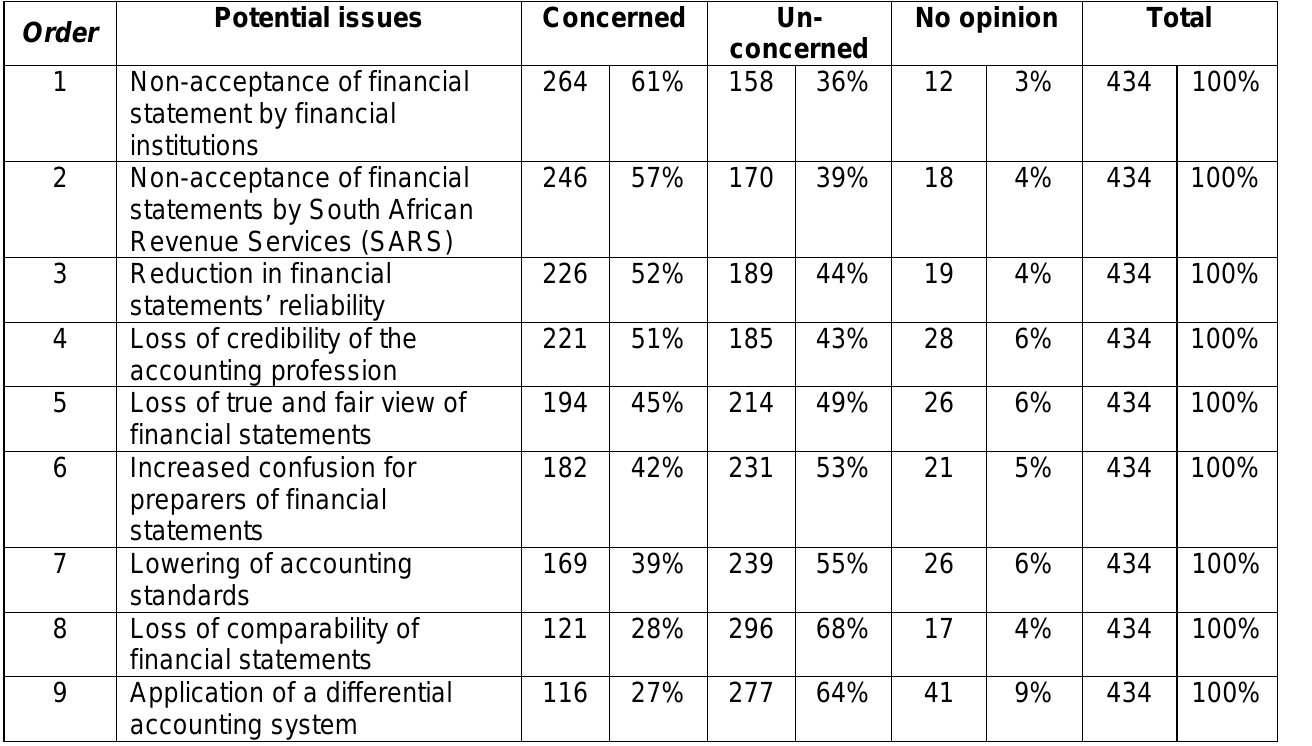
Table 3: Potential issues regarding relaxation of accounting standards